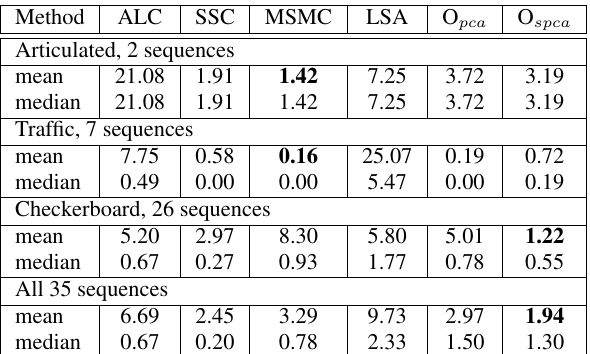
Table 1: Mean and median of the misclassification (%) on the Hopkins 155 dataset with 2 motions.